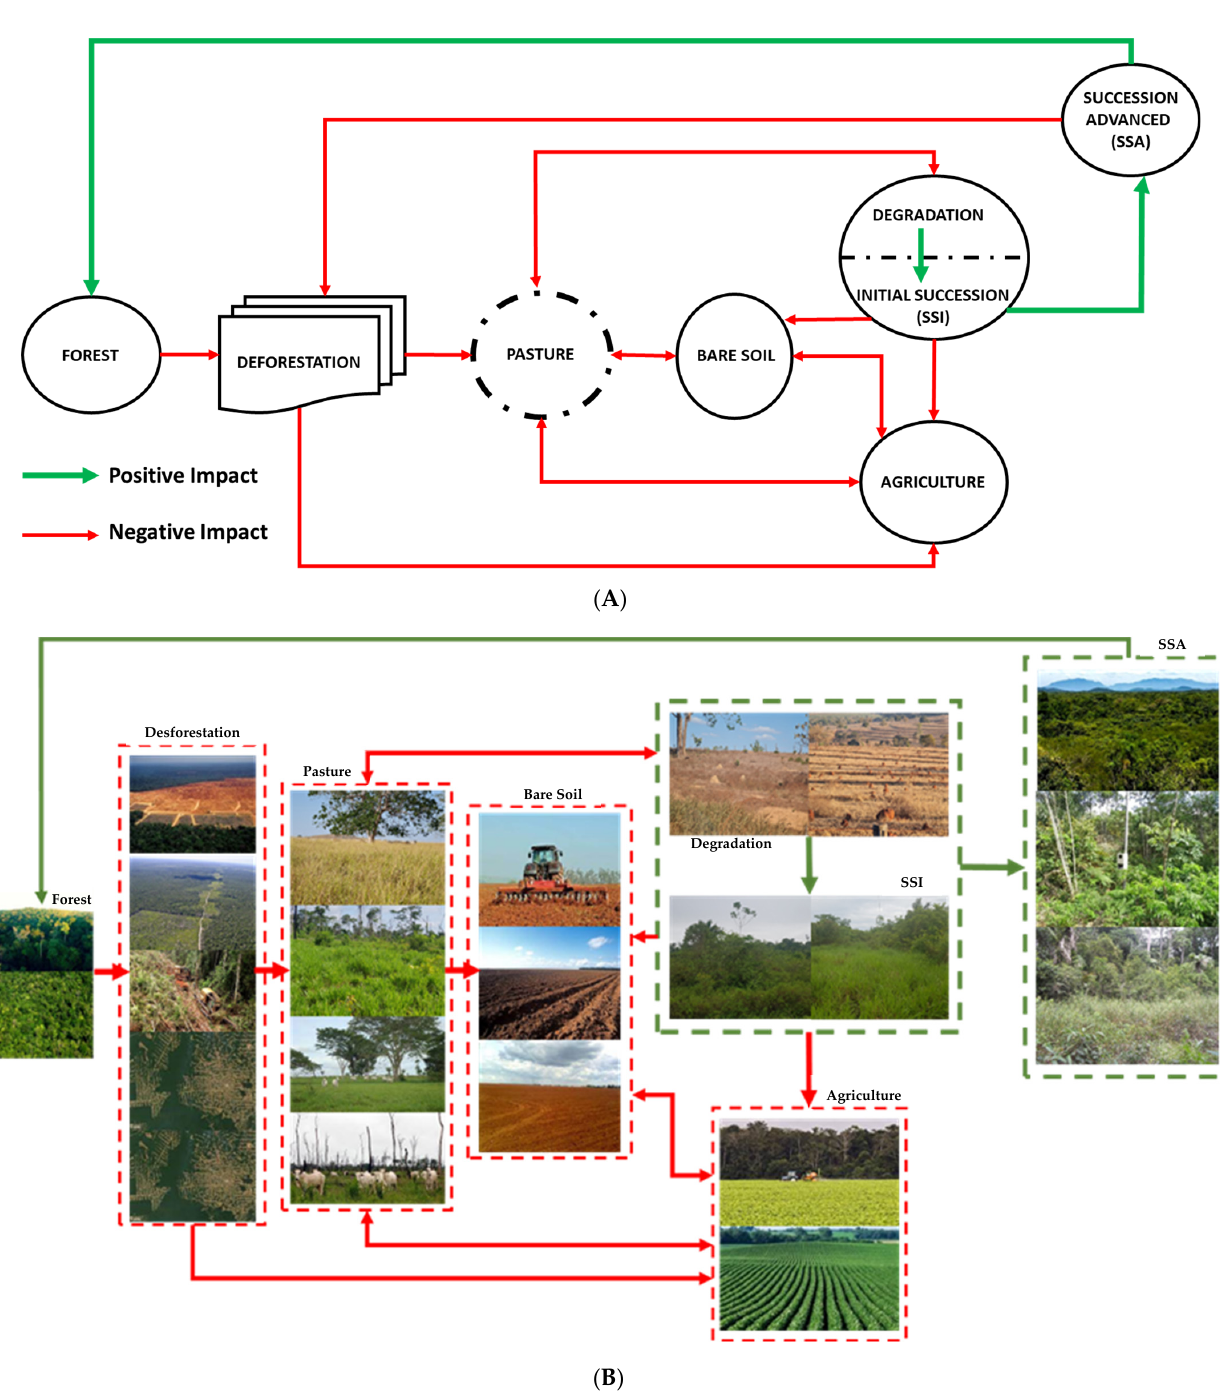
Figure 7. Path dynamics of land use and occupation in the Machadinho and Anari settlements corresponding to the occupancy model denominated fishbone and topographic or disorganized multidirectional, average from 1984 to 2020. The red arrows represent the anthropization of native vegetation (forest), causing negative impacts; the green arrows, on the other hand, demonstrate the emergence of secondary vegetation (secondary succession) characterizing the positive impacts for the regeneration of the forest class. ( A ) LULC dynamic and ( B ) LULC dynamics illustrated. Degradation was defined as a function of the characteristics found in loco. Where each class of interest had particular characteristics. For example, in the pasture area, this is considered degraded when it reduces the carrying capacity.